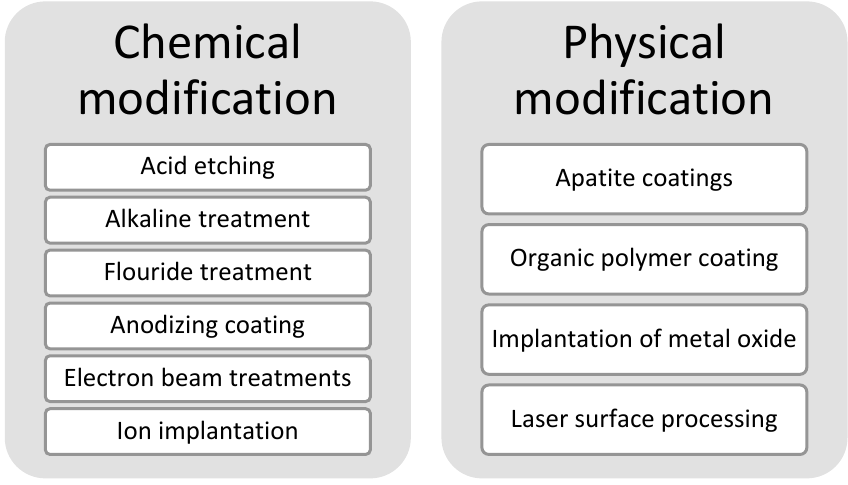
Figure 2. Methods of surface modification.